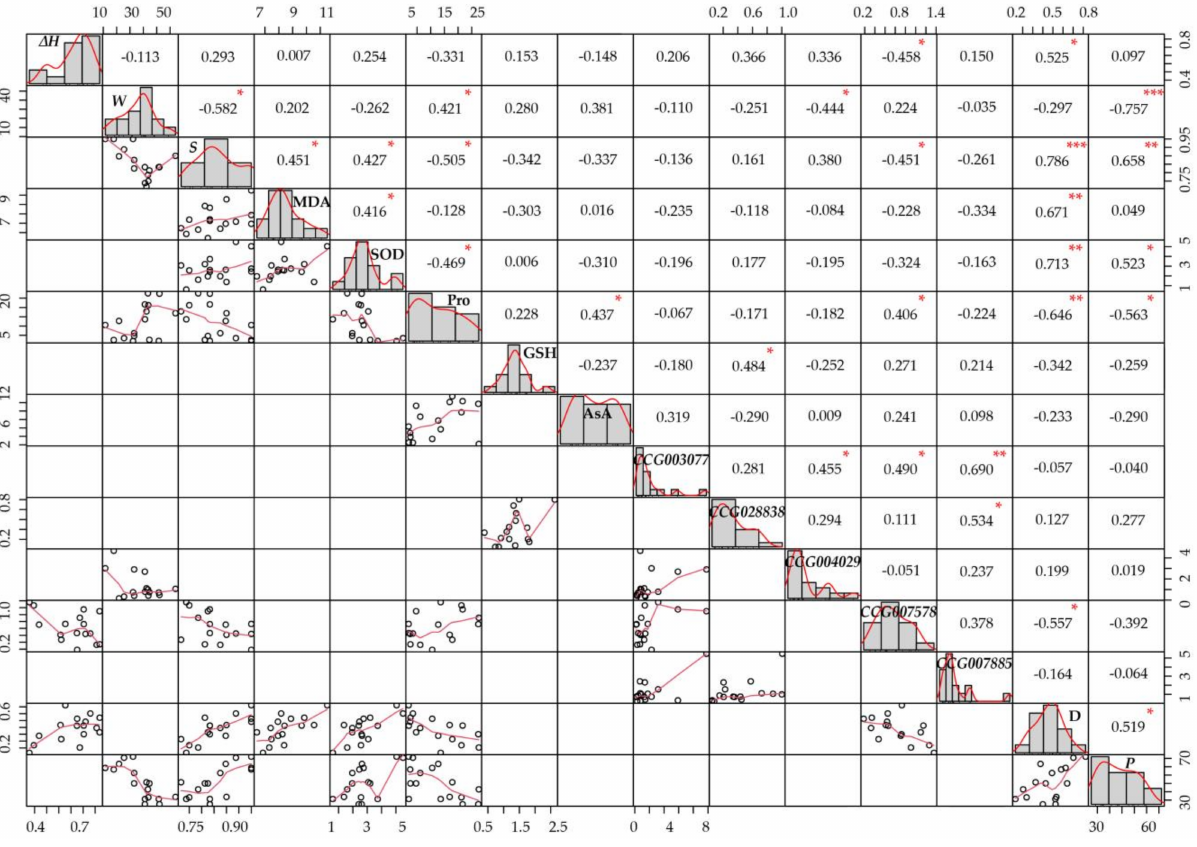
Figure 5. Analysis of correlations among indices. “*”: p < 0.05; “**”: p < 0.01; “***”: p <